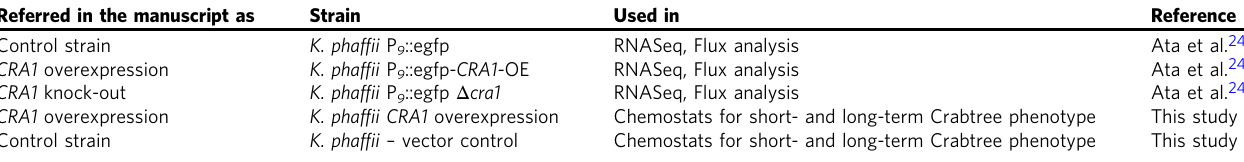
Table 2 K. phaf fi i strains used in the